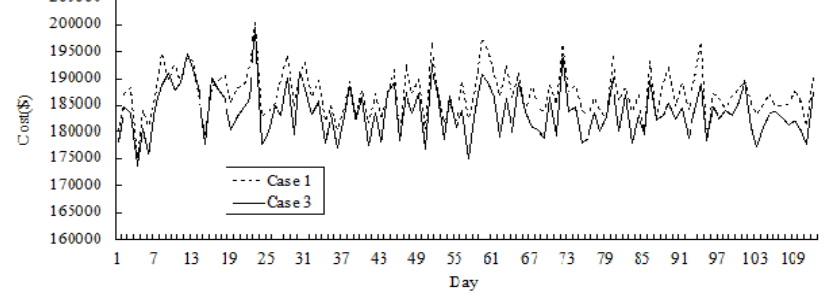
Figure 4. Comparative results of cost variation for Cases 1 and 3 (for 112 days).